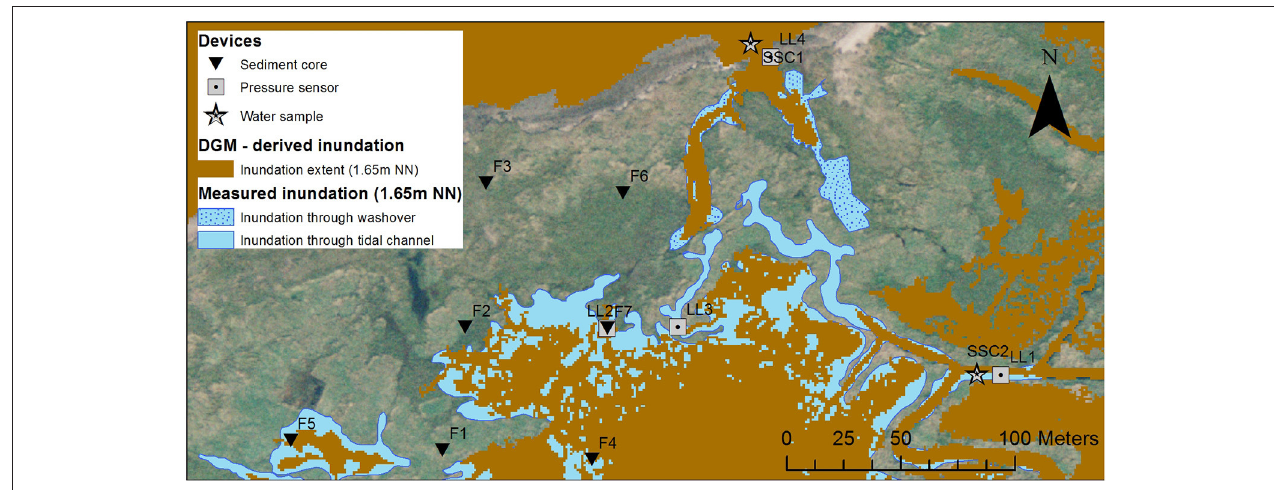
FIGURE 6 | Map of inundated marsh areas on 15 March 2014 (blue and blue dotted areas). Blue areas indicate flooding through the tidal channel system. Blue-dotted areas indicate flooding through the overwash breach. Brown-colored areas indicated the inundation pattern derived from the Digital Elevation Model (DGM), assuming an inundation height of 1.65m (NHN).